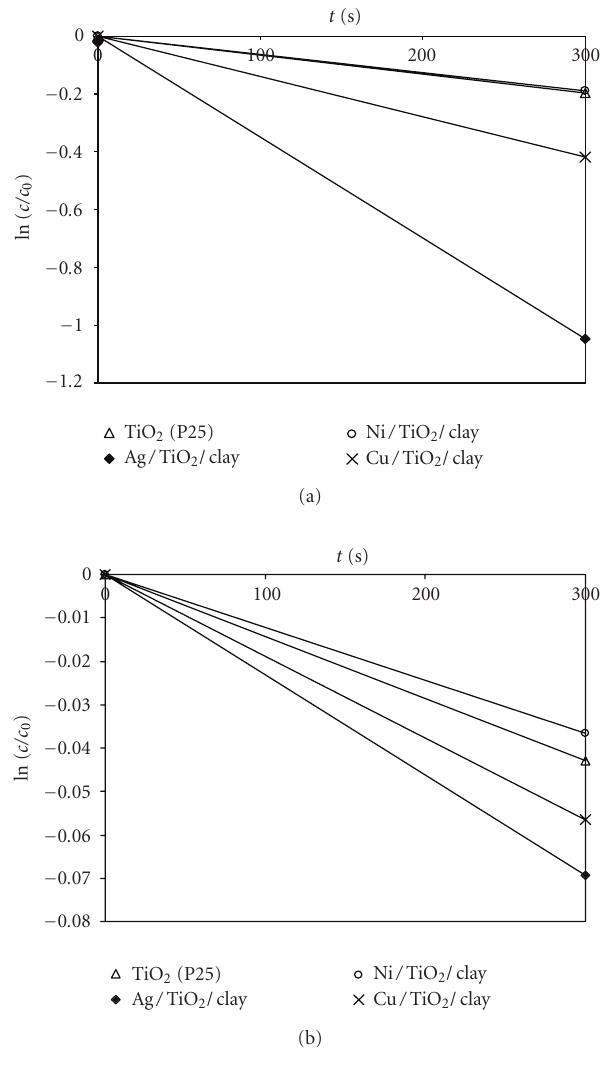
Figure 8: Determination of rate constants ( k ) with ln( c/c 0 ) versus t (sec) function by using (a) “light source 1” and (b) “light source 2” lamps.